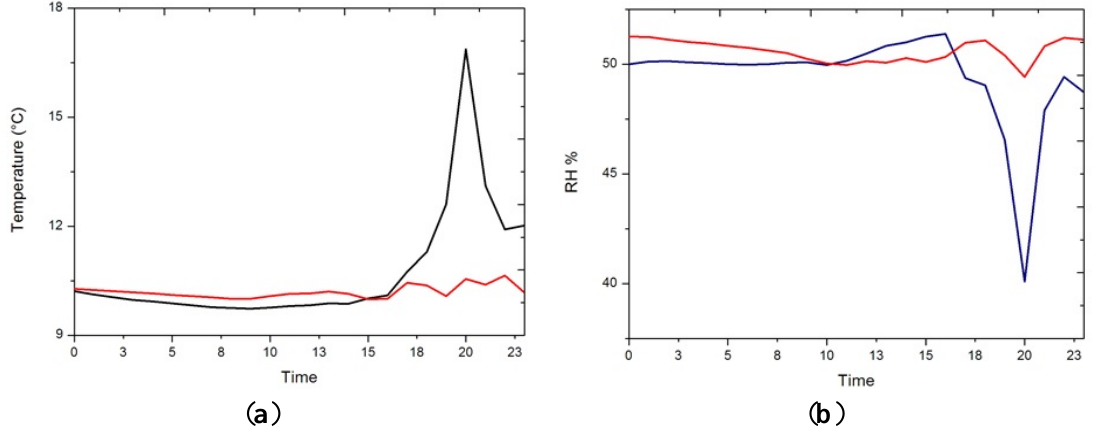
Figure 10. Daily mean trajectories of sensors #1, #4, #8, #12, for Saturday (black) and Monday (red), from 2/1/2012 to 5/5/2012 (period when heating strategies are followed), ( a ) temperature, ( b )